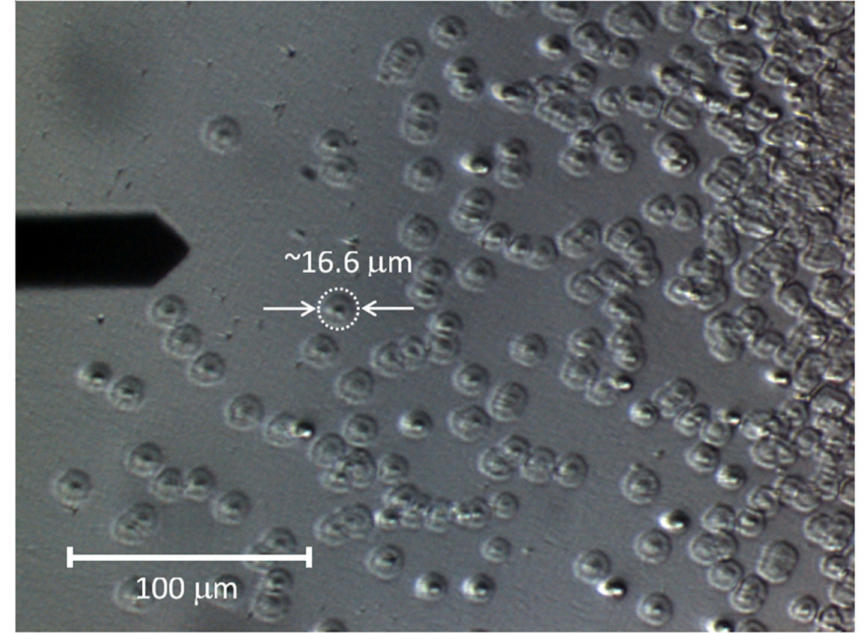
Figure 4. Di ff erential interference contrast (DIC) image of the surface of explanted IOL. The characteristic shape of a single sediment structure is shown in Figure 5, presenting an AFM height image and height line profiles. The conical, central part of the structure and its quickly falling edges are clearly visible. Statistical analysis of DIC and AFM images allowed to determine the average diameter and height of the islands as well as their standard deviations. The diameter values are 16.56 ± 2.55 µ m for DIC and 15.32 ± 2.19 µ m for AFM (for sample size n = 30). The height determined on the basis of the AFM measurements is 550.2 ± 68.5